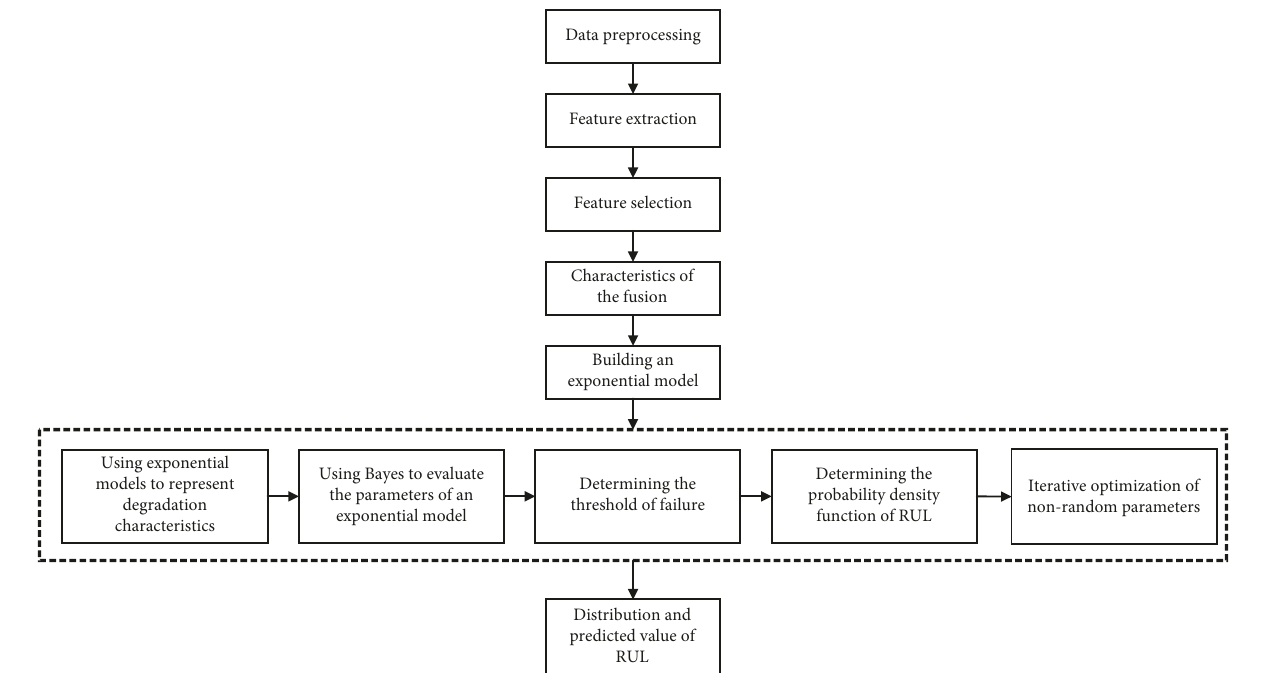
Figure 1: RUL prediction process of exponential degradation